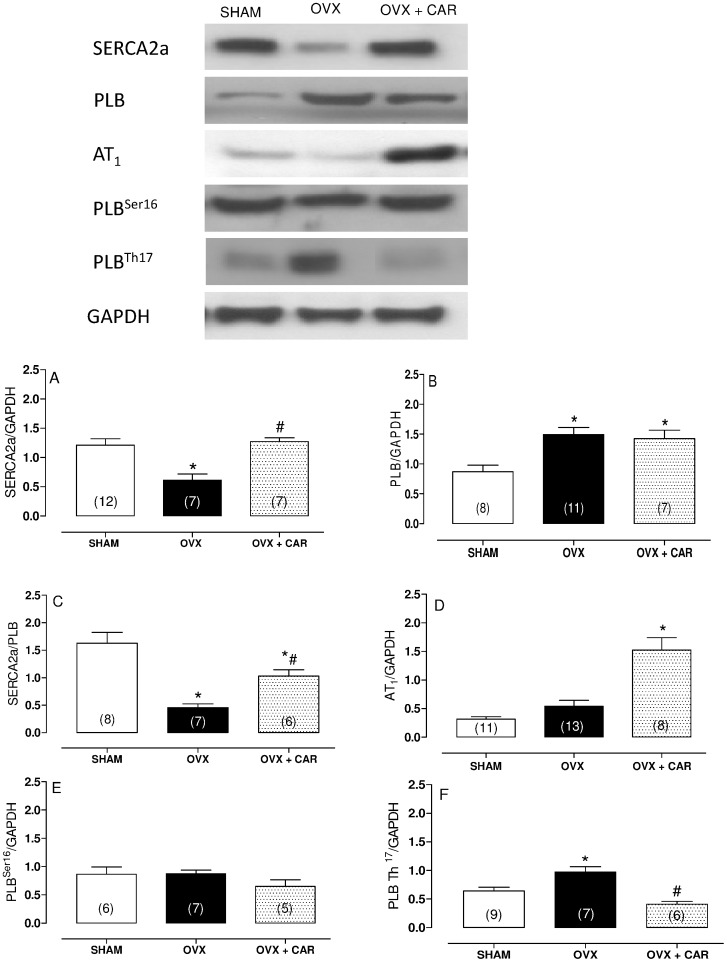
Densitometric analysis of Western blots.SR Ca2+-ATPase (A), (B) phospholamban (PLB), (C) SERCA2a/PLB ratio, (D) AT1 receptor, (E) phosphorylated phospholamban at Ser16 (PLBSer16) and phosphorylated phospholamban at Thr17 (PLBThr17) in hearts from SHAM, Ovariectomized (OVX), Ovariectomized plus carvedilol (OVX+CAR) rats. The values are expressed as the means ± S.E.M * p<0.05 vs. SHAM rats. # p<0.05 vs. OVX rats using one-way ANOVA and Tukey post hoc test. Number of animals in indicated in parenthesis. Representative blots are shown.